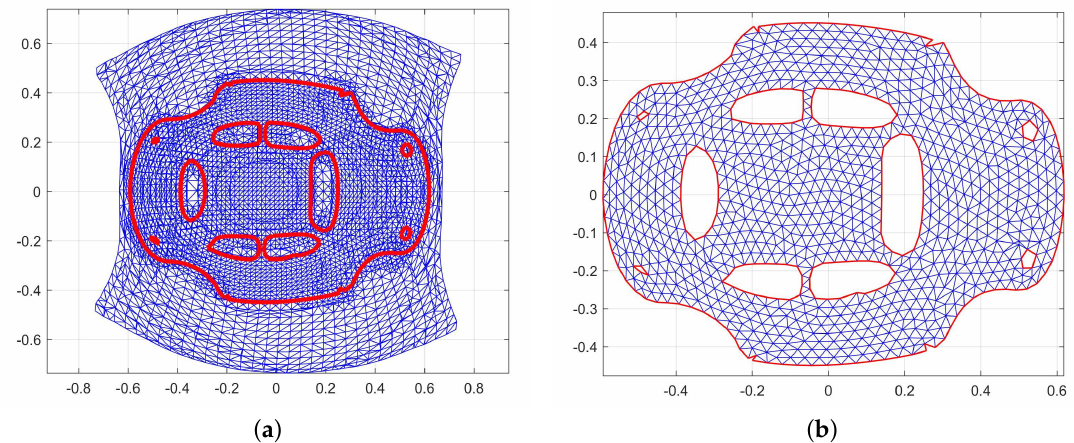
Figure 9. Parameterization of the Poisson surface M ∗ and its corresponding trimmed parameterization Φ . ( a ) Mesh parameterization of the Poisson surface M ∗ . ( b ) Trimmed parameterization Φ .